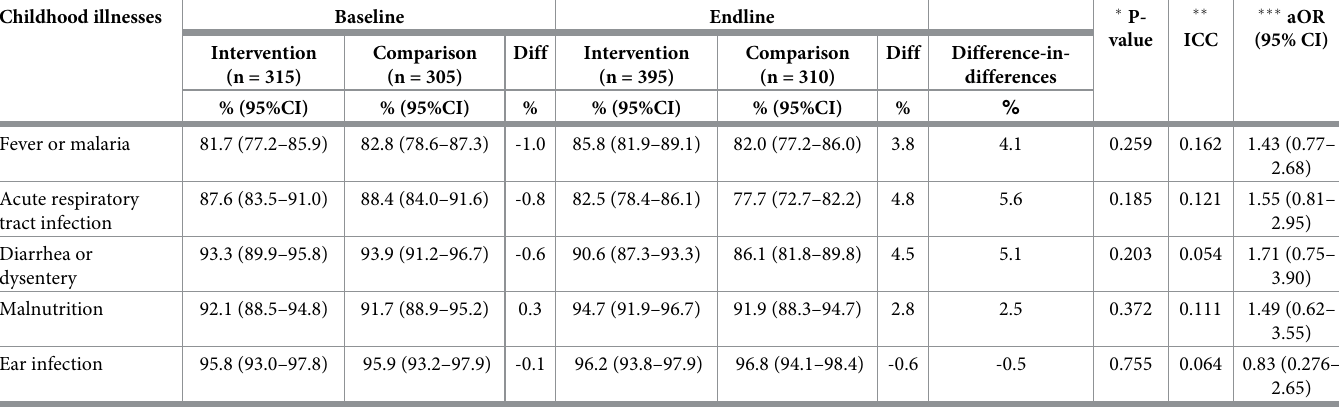
Table 2. Correct classification of childhood illnesses among children 2–59 months of age in baseline (December 2016- February 2017) and endline surveys (Decem- ber 2018-February 2019) in intervention and comparison areas. Childhood